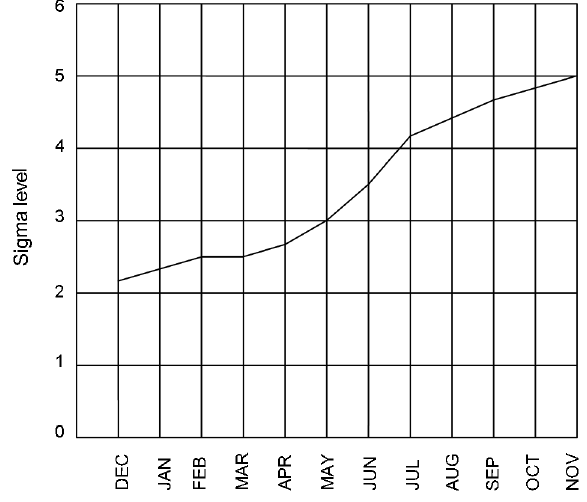
Fig. 3. Sigma level of the current